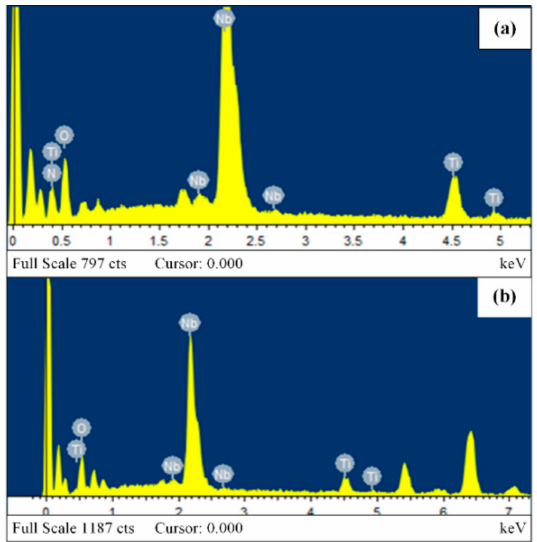
Figure 3. Energy dispersive spectrometry (EDS) results of ( a ) TiNbN / 316L SS and ( b ) TiNb / 316L